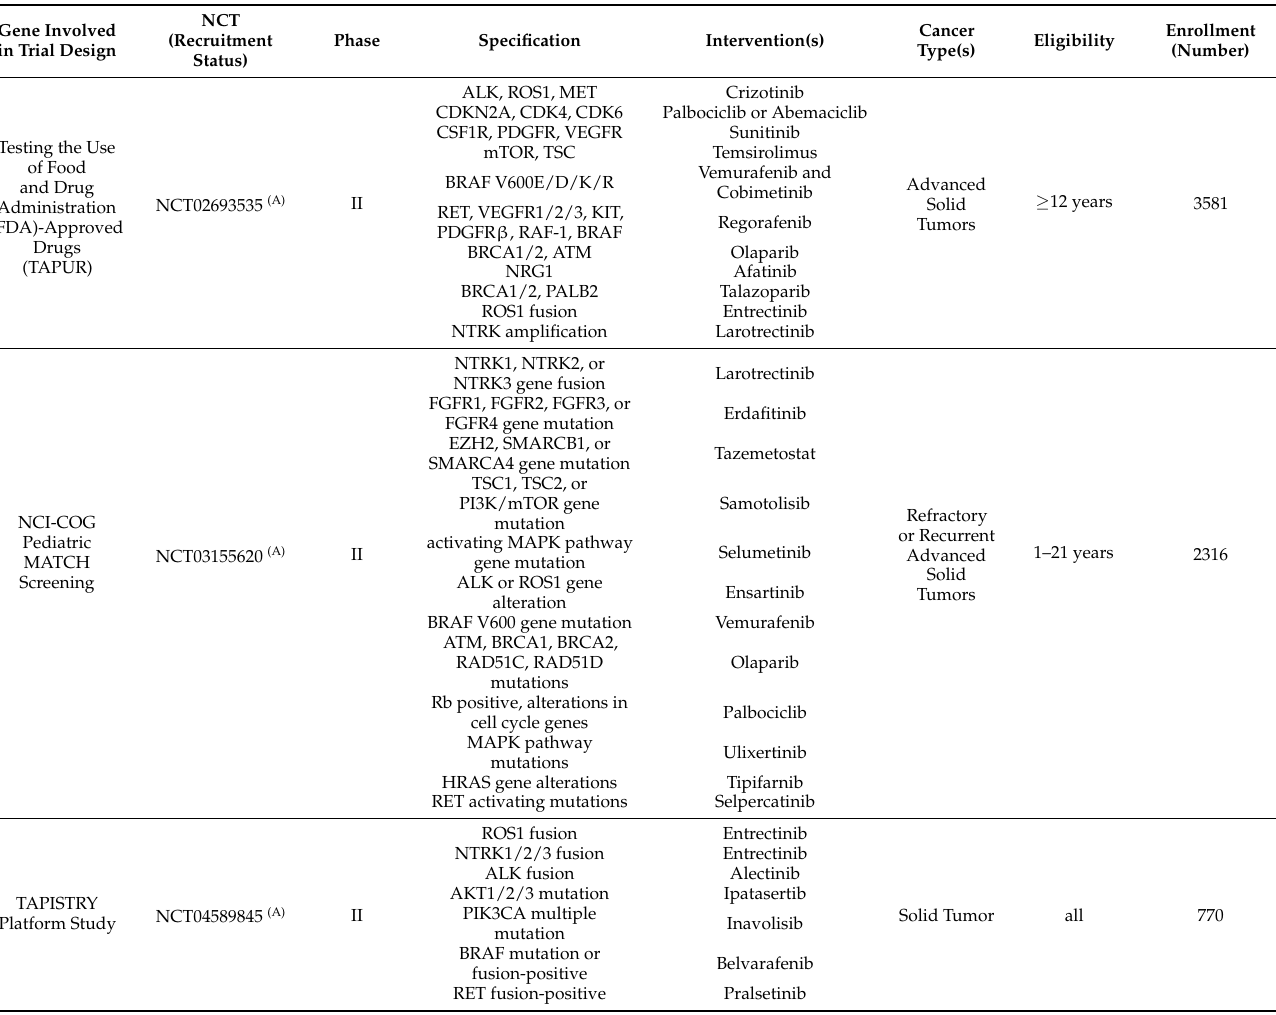
Table 6. Precision study designs for pediatric cancer: Multiple-arm